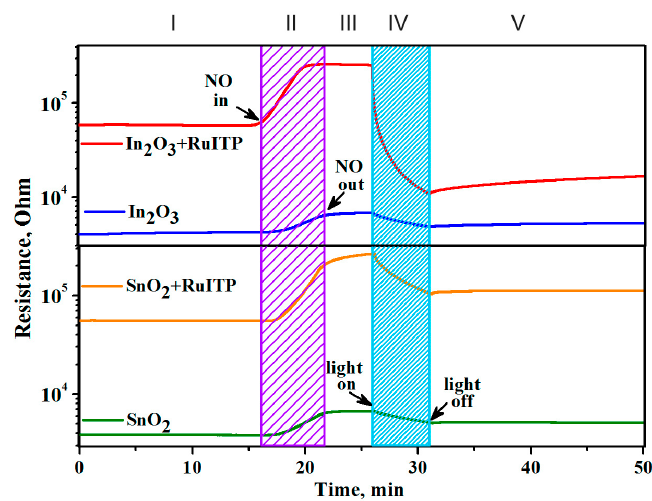
Figure 7. Room temperature resistance of unmodified oxides SnO 2 and In 2 O 3 and hybrids SnO 2 +RuITP and In 2 O 3 +RuITP in the presence of 4 ppm NO in dark conditions and under blue light LED illumination ( λ max = 470 nm). I—air, dark conditions; II—in the presence of target gas, dark